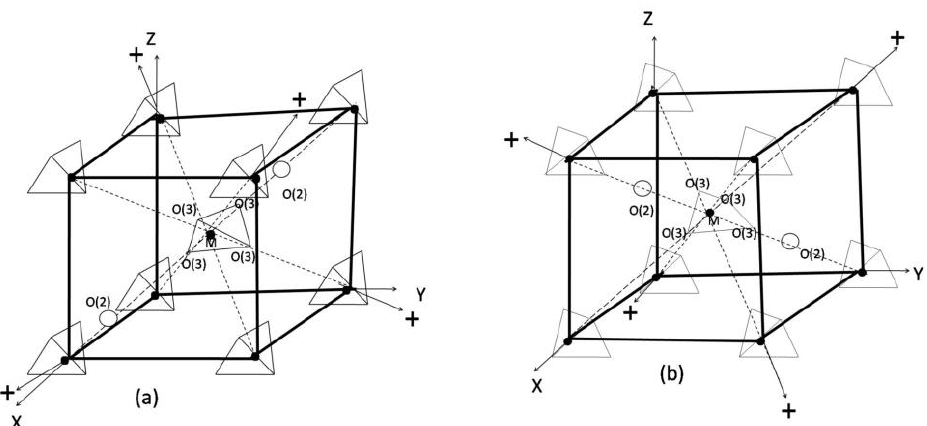
Figure 2. One unit cell of Bi MO showing the M–O tetrahedron and the polarization 12 20 direction resulting from compression along [111]: ( a ) dextrorotatory; ( b ) laevorotatory [2] (Reprinted/Reproduced with permission from [2]. Copyright 1967 AIP Publishing LLC).